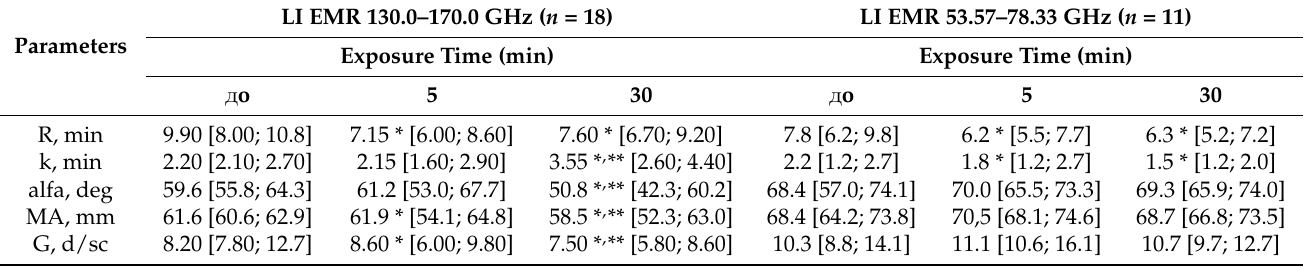
Figure 3. Dynamics of passive factors of regulation under various factors of influence on a burn wound. Note: R — respiratory factor, C — cardiac component, * — differences are statistically signifi- cant compared to intact rats ( p < 0.05); ** — differences are statistically significant compared to CThB controls ( p < 0.05). Table 2. Dependence of the dynamics of the viscoelastic properties of blood on the EMM spectrum and exposure to